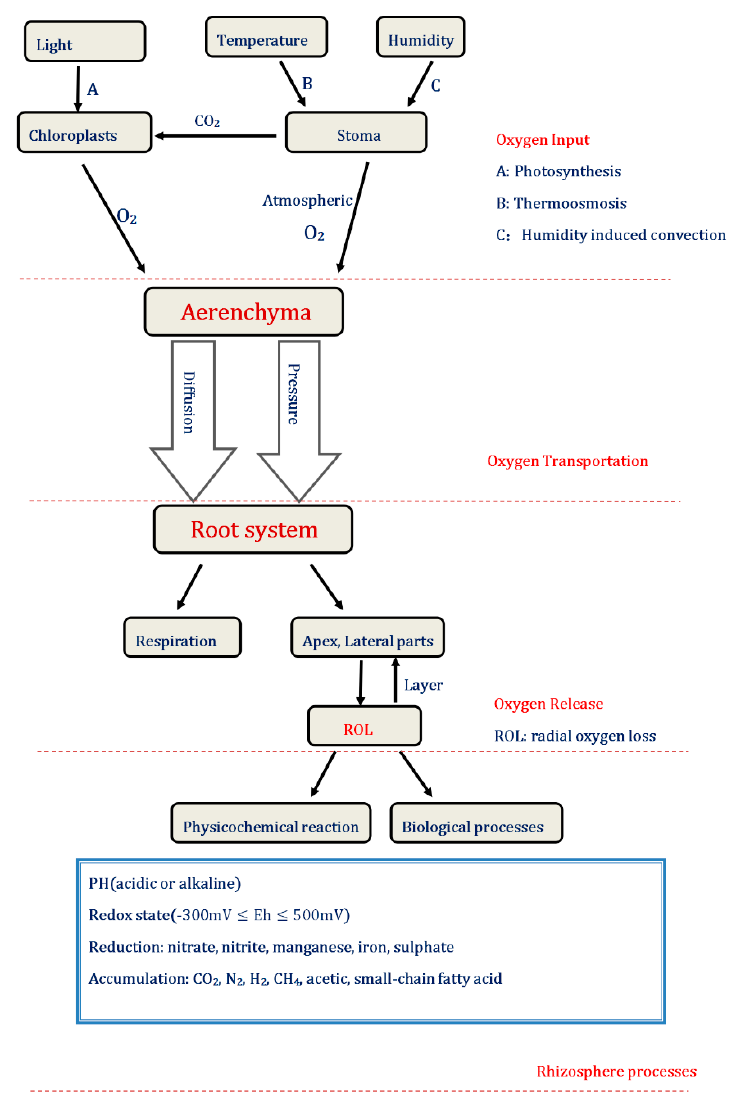
Figure 2. Schematic diagram of the ROL.